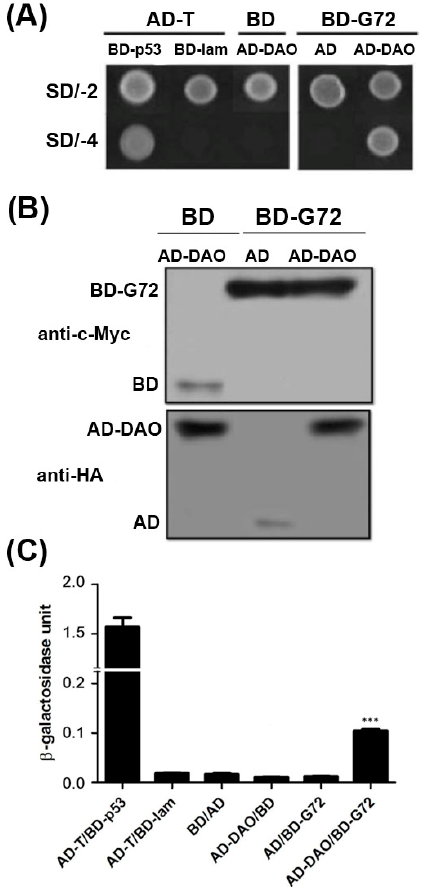
Figure 1. G72 interacts with D -amino acid oxidase (DAO). ( A ) Yeast co-transformed with plasmids containing the genes for AD-DAO and BD-G72 were viable on SD/-2 and SD/-4 plates; ( B ) Western blotting confirmed that AD-DAO and BD-G72 were expressed in the yeast system. Anti-c-Myc was used to detect the DNA-binding domain (BD), and anti-HA was used to detect the activation domain (AD); and ( C ) Relative interaction strength between DAO and G72 was determined using the β -galactosidase activity assay. *** p < 0.001 compared with the interaction of BD and